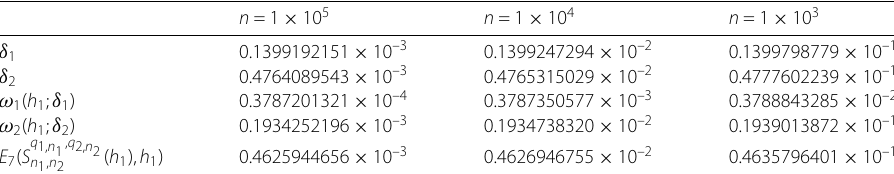
q 1, n 1 , q 2, n 2 n 1 , n